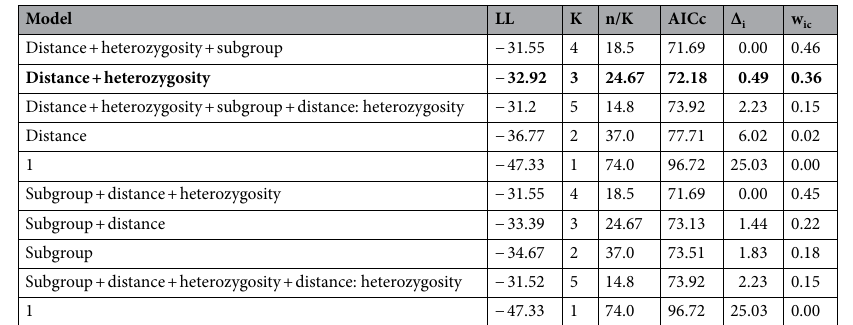
Table 1. Binomial model comparisons of the probability to be PCR-positive for at least one Entamoeba polecki OTU in Yunnan snub-nosed monkeys, related to predictor variables. LL, Maximized log-likelihood; K, Number of estimated parameters; n/K, number of observations/K; AICc, Akaike’s Information Criterion; Δi, difference between AIC and the lowest AIC value; wic, Akaike weight. The final selected model is in bold.